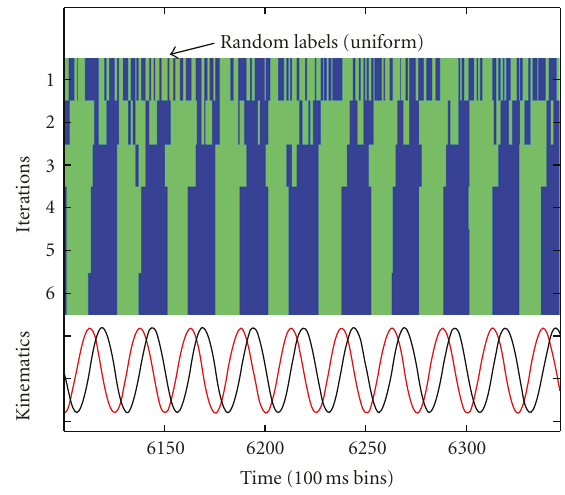
Figure 5: LM-HMM cluster iterations (Two classes, k =